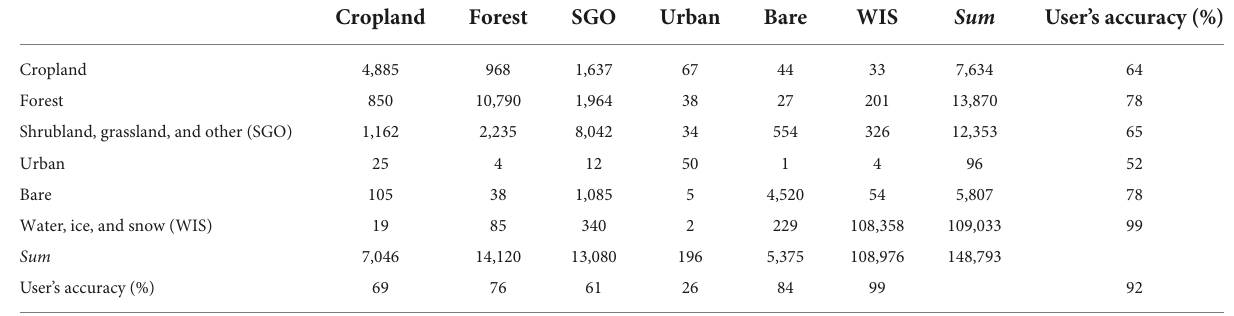
TABLE 3 The confusion matrix of the ESA-CCI and GlobCover maps for 2009.